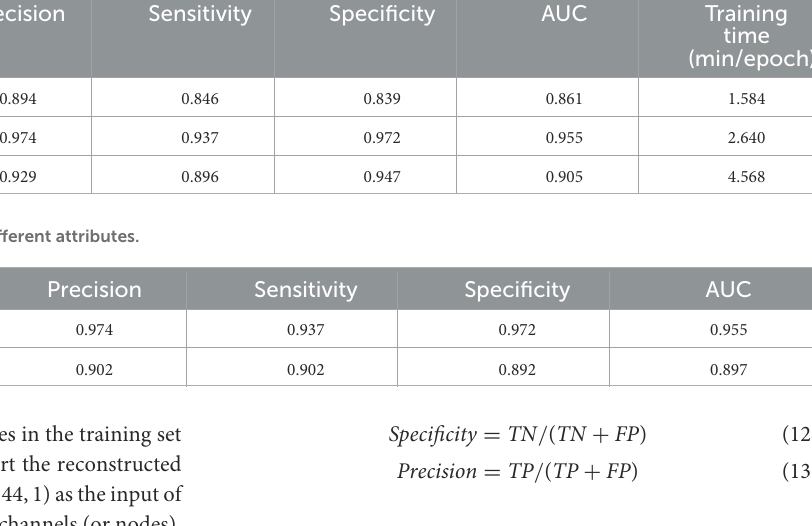
TABLE 1 Comparison of experimental results for different sliding window lengths. Sliding window